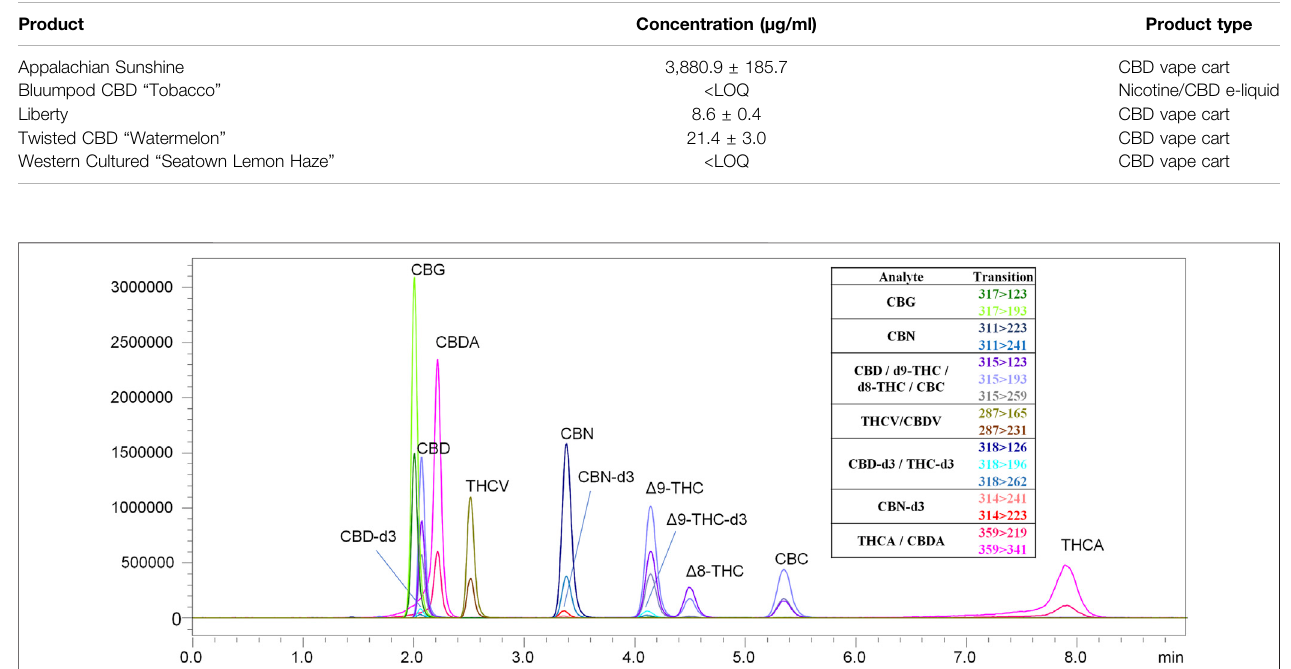
FIGURE 6 | LC-MS/MS chromatogram produced from a mixed cannabinoid calibration standard. The chromatographic method employed was able to separate analytes with identical MRM transitions.